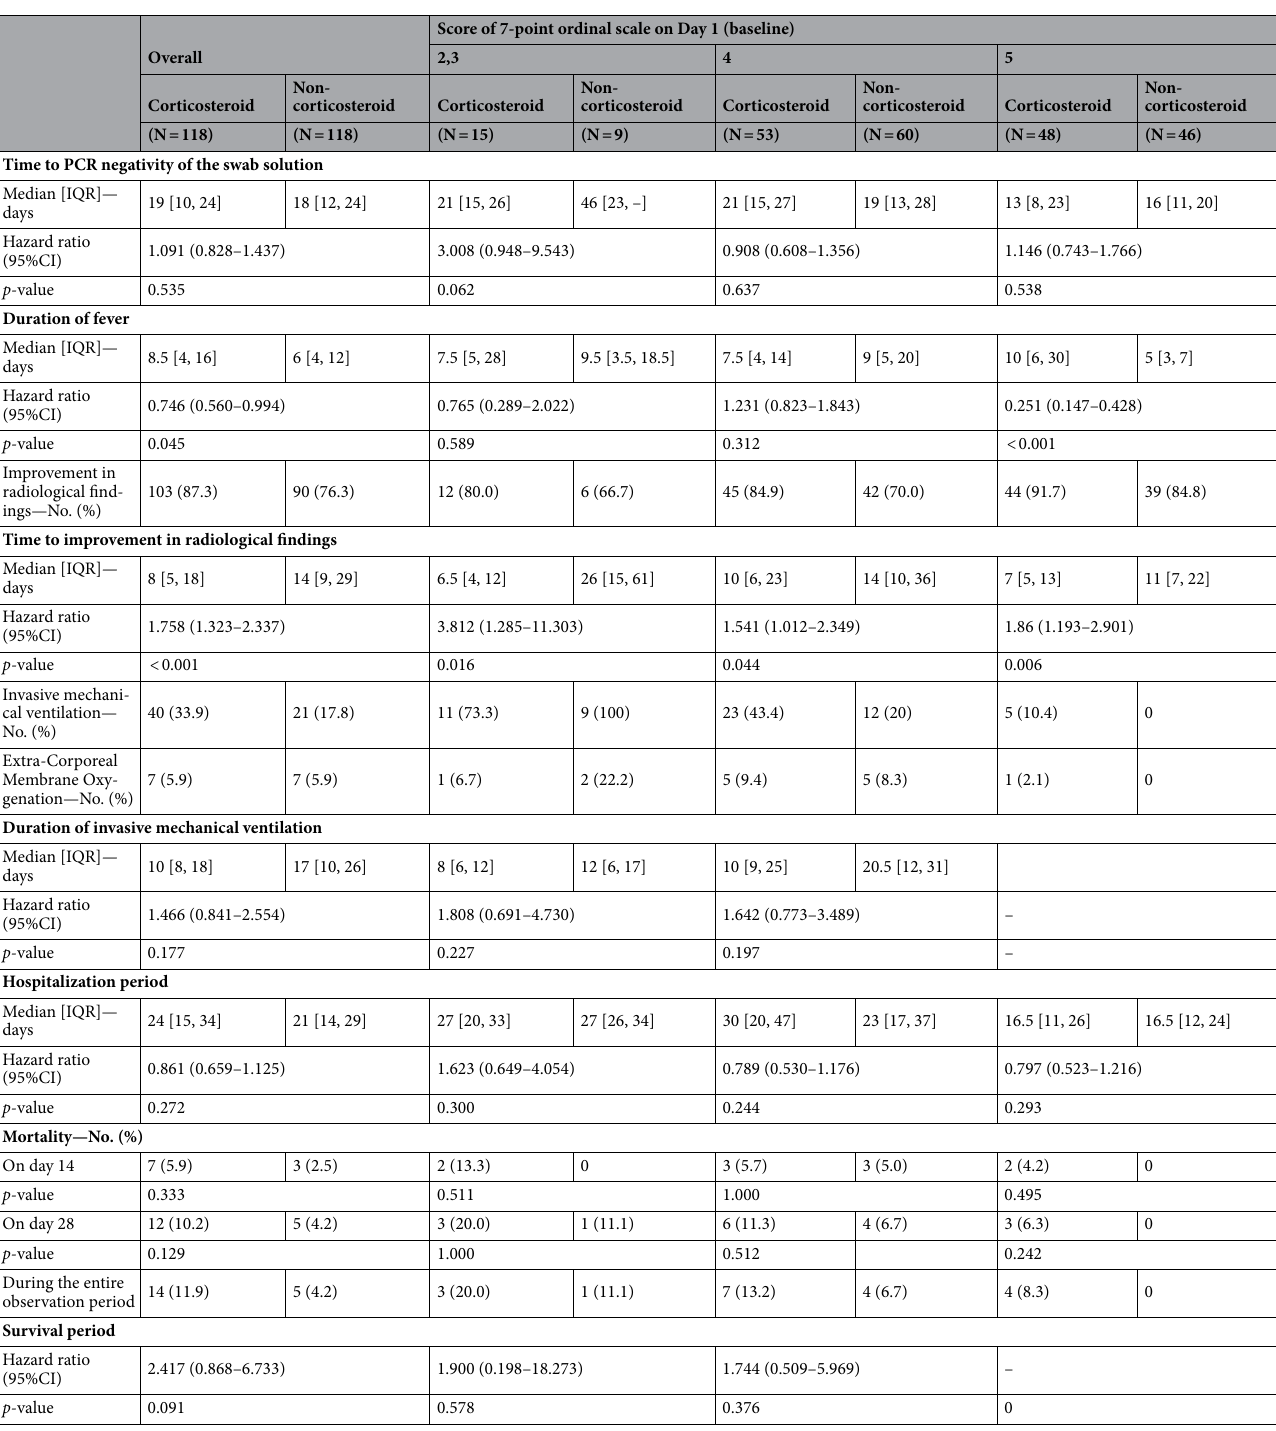
Table 4. Secondary outcomes. Because only a few patients had a baseline 7-point ordinal score of 3, the patients with a baseline score of 2 and 3 were combined for the analysis. Categorical variables were presented as numbers (%). IQR, interquartile ranges; CI, confidence interval; PCR, polymerase chain